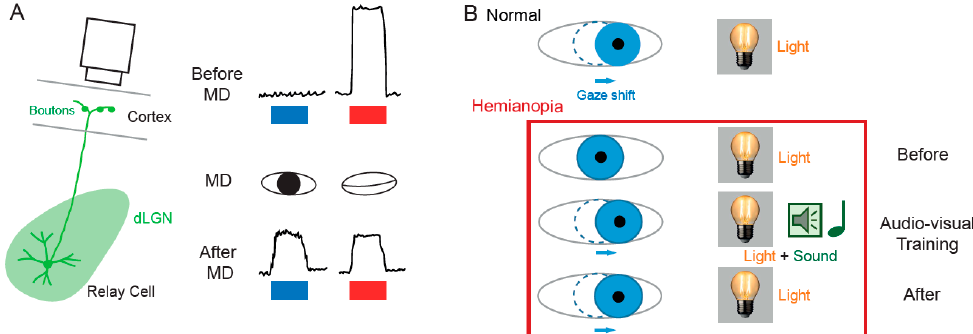
Figure 2. Functional plasticity in subcortical visual areas. ( A ) In the dLGN. Left, calcium imaging setup in presynaptic boutons of dLGN relay cell. Right, calcium signals evoked by visual stimulation (blue bar, stimulation of the right eye; red bar, stimulation of the left eye). Upper part, before MD; middle part, MD; lower part, after MD. Visual response is evoked only through one eye before MD, whereas visual response is evoked through each eye after MD on the left eye (adapted from [38]). ( B ) In the SC. In normal patients, gaze orientation occurs upon visual stimulation (light). In hemianopia patients, the same light stimulus produces no gaze shift. During audio-visual training where light is associated with a sound localized in the same region of space, gaze shift occurs. After training, light alone produced a gaze shift (adapted from [41,42]).